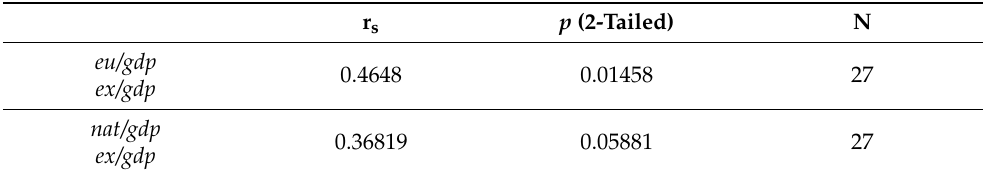
Table 11. Spearman’s Rho correlation coefficient between the ratios eu/gdp and ex/gdp , and nat/gdp and ex/gdp .